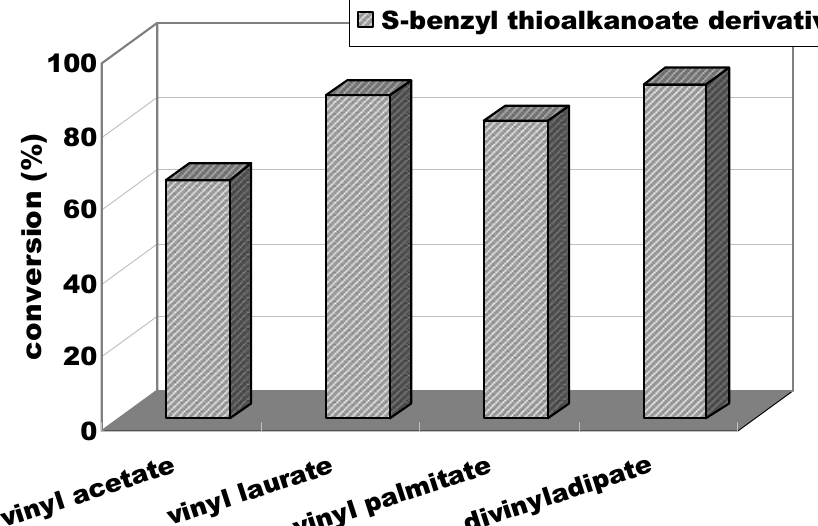
Figure 6. The effect of acceptor structures on the enzymatic synthesis of thioesters in a continuous flow microreactor. 10.4 µ L min − 1 feed 1 (4 mmol thiol derivatives in 10 mL DMSO) and 10.4 µ L min − 1 feed 2 (8 mmol vinyl esters in 10 mL DMSO) at 50 ◦ C (residence time 30 min), Lipozyme TL IM (0.87 g, 44 mg mL − 1 ).